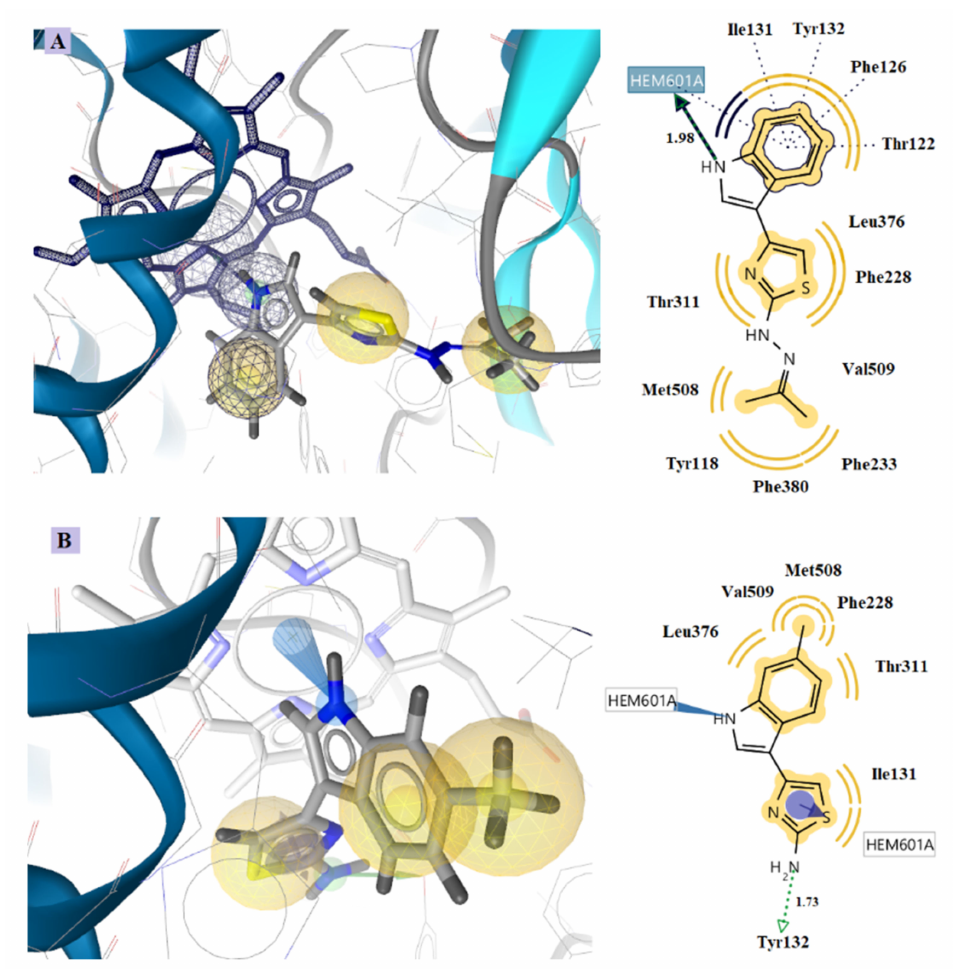
Figure 6. Docking of the most active compounds 5x ( A ) and 5d ( B ) to CYP51Ca receptor. Red and green dotted arrows indicate H-bond, blue arrows aromatic interactions and yellow spheres hydrophobic interactions.